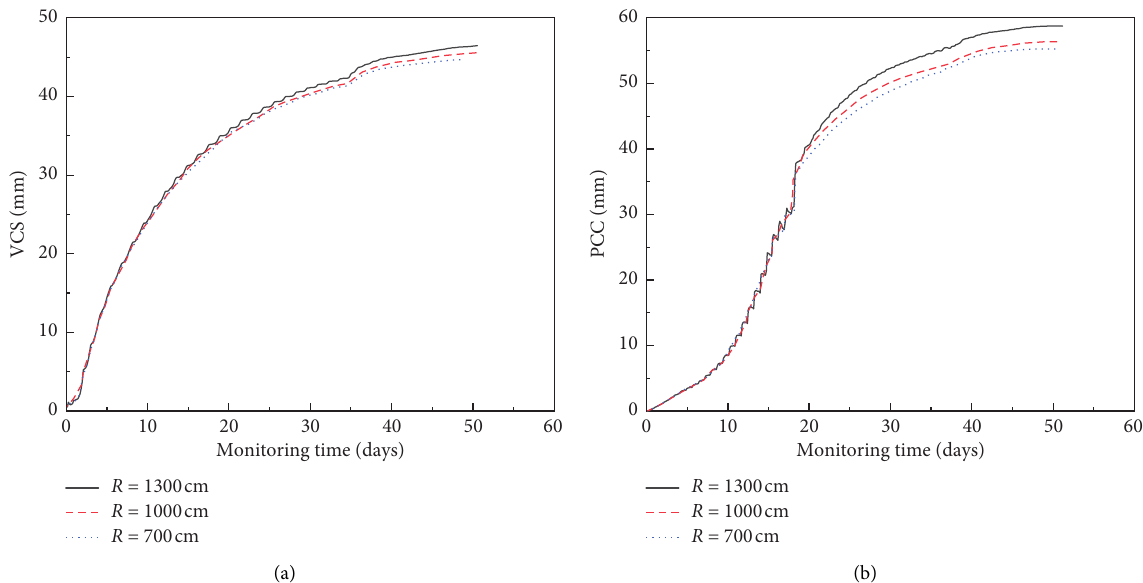
Figure 16: Deformation of the double-layer steel arch with equal rigidity. (a) The VCS under different radii of the invert. (b) The PCC under different radii of the